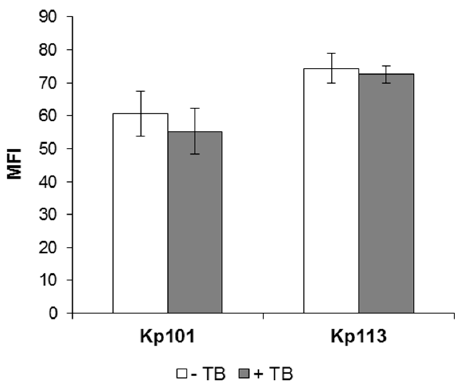
Figure 3. Evaluation of Bac7(1–35) internalization into K. pneumoniae Ts101 and Ts113 strains. Fluorescence of KpTs101 and KpTs113 cells exposed for 10 min to 0.25 µM Bac7(1–35)-BY was reported. Bacterial cells (1 × 10 6 CFU/mL) were incubated with peptide, extensively washed, and analyzed by flow cytometry with ( grey columns) or without ( white columns) incubation with 1 mg/mL TB for 10 min at 37 °C. Data are expressed as the average of mean fluorescence intensity (MFI) ± SD from three independent experiments.